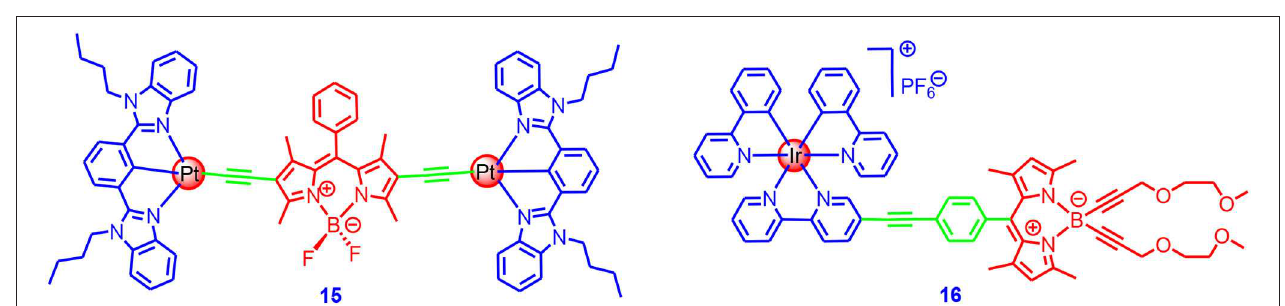
FIGURE 4 | Ru(II) complex containing Bodipy appendants.